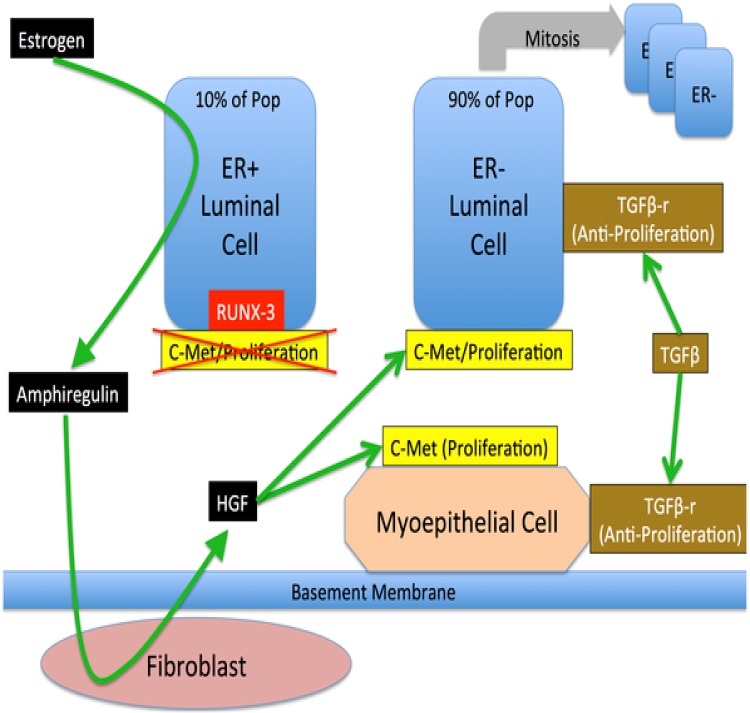
Overview of paracrine signaling involved in maintenance of the breast ductal epithelium in the Duct Epithelium Agent-based Model (DEABM).In normal breast tissue ER+ luminal cells respond to estrogen by producing amphiregulin, which stimulates production of the mitogen Hepatocyte growth factor (HGF) by fibroblasts. HGF in turn stimulates proliferation in ER- luminal cells and myoepithelial cells by binding to C-Met. Figure reproduced from [18] under the Creative Commons Attribution license.